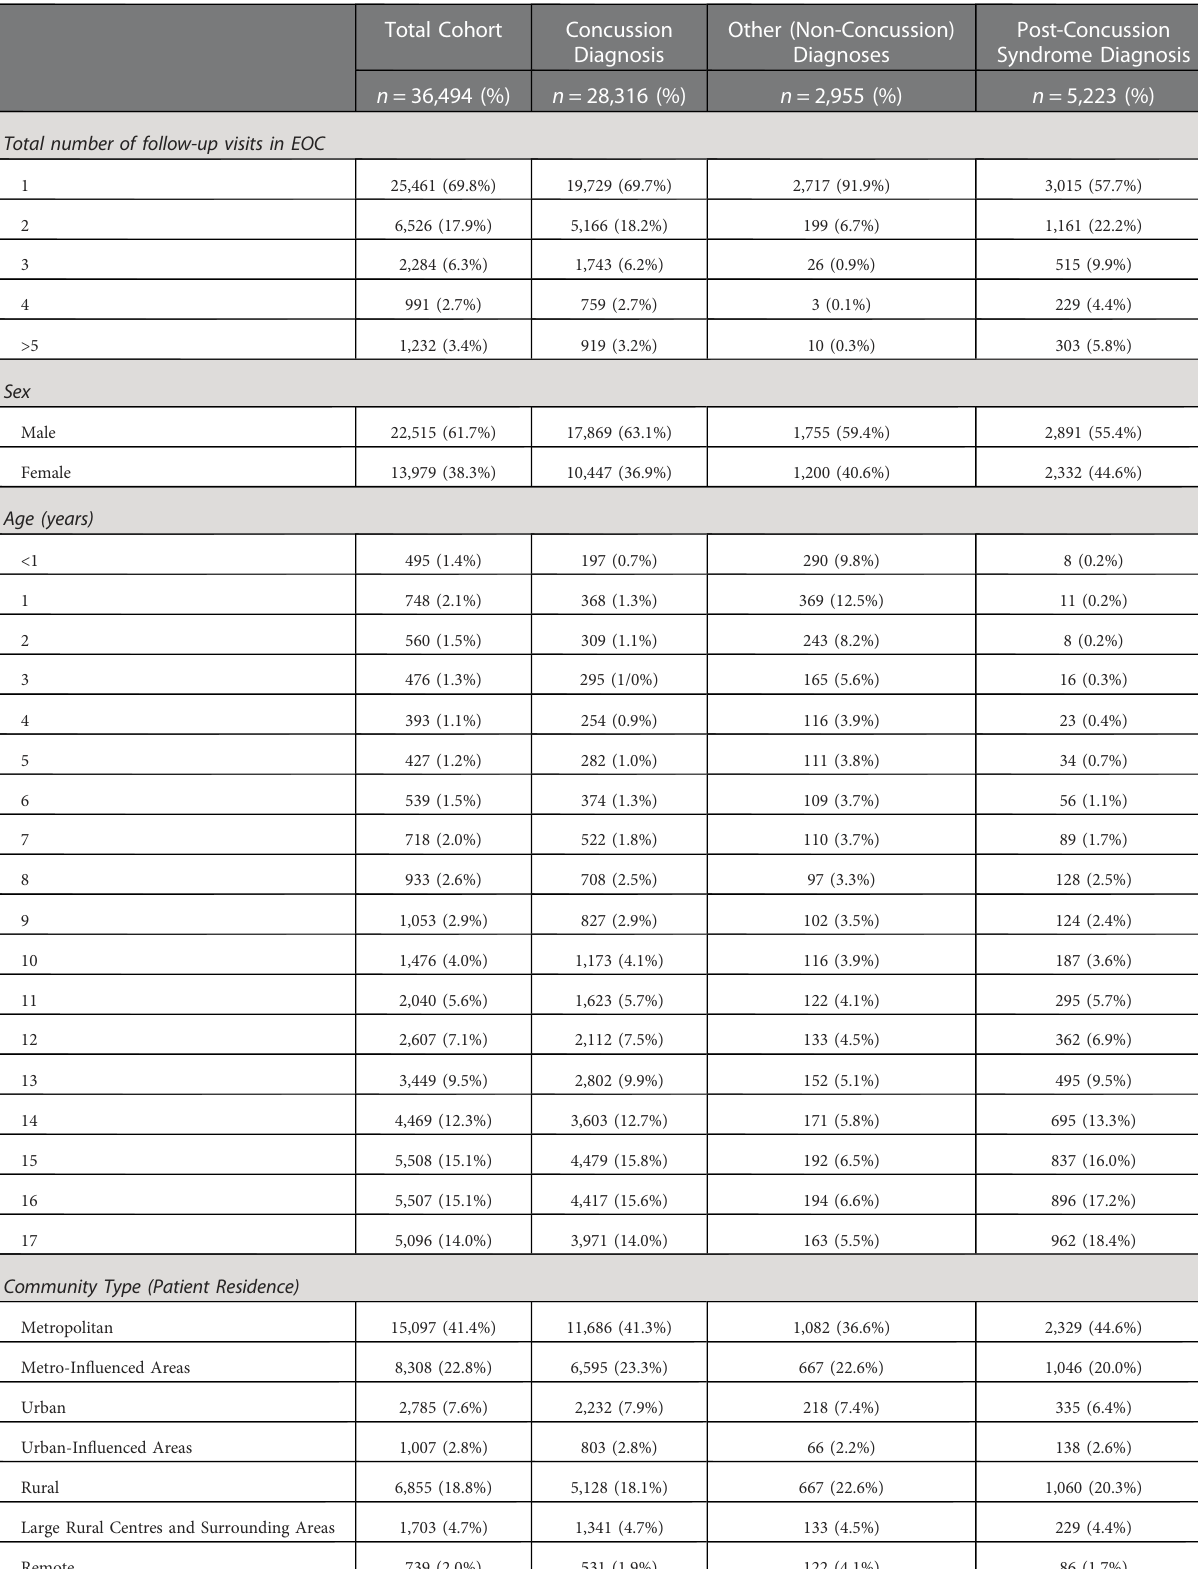
TABLE 4 Patient demographics for pediatric concussion, post-concussion syndrome, other speci fi ed injuries of head, and unspeci fi ed injury of head follow-up visits occurring in ED or PO settings between April 1, 2004 and March 31, 2018 in